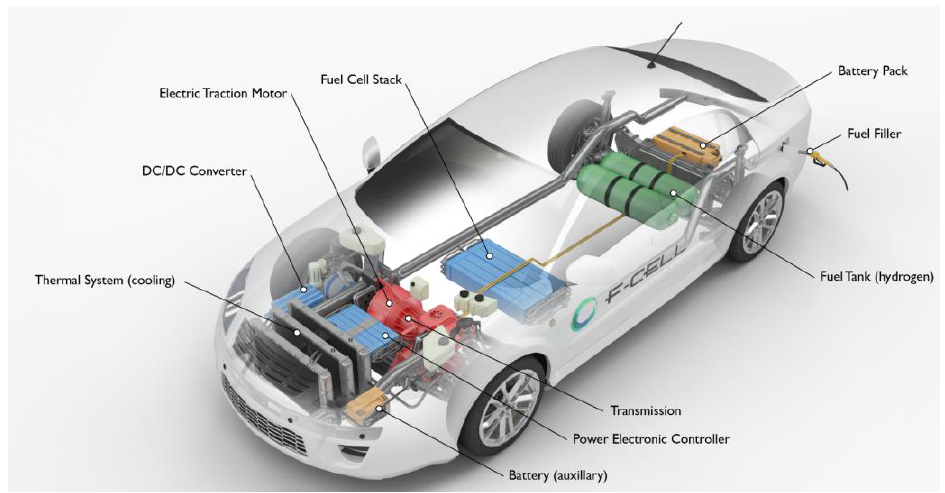
Figure 1. Fuel cell vehicle with on-board storage [29].